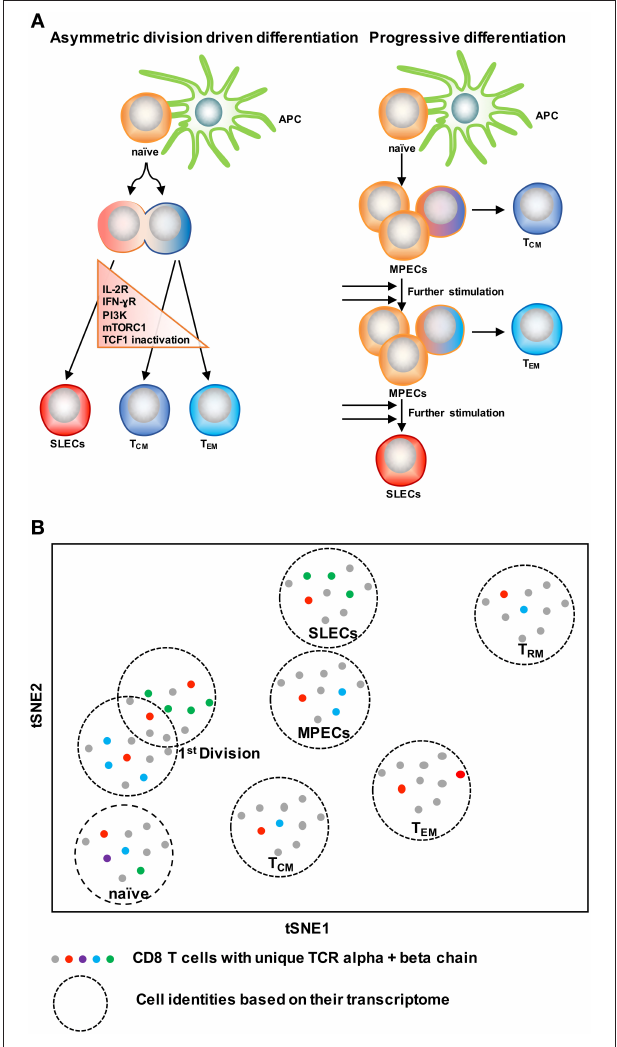
FIGURE 4 | Two CD8T cell differentiation models. (A) The asymmetric division model emphasizes the significance of asymmetric segregation of cytokine receptors and signals pathways as early as the first division in dictating the memory or effector potential of T cells. The proximal daughter cell (red) inherits molecules that make it more likely to become an effector cell, while the distal daughter (blue) inherits more memory-related molecules. The progressive differentiation model is a linear model in which the cumulative history of encounters with antigen and inflammation dictate the cell fate from a memory-like stage to terminally differentiated cells. (B) A method to depict “one cell, one fate” and “one cell, multiple fates” models. Single cell identity of a T cell can be profiled based on their transcriptome using scRNA-seq. TCRs are nature molecular tags to track T cells. Integration of TCR clonotypes to a gene expression profile on a single-cell level can monitor the dynamics of effect and memory CD8T cell fate decision during